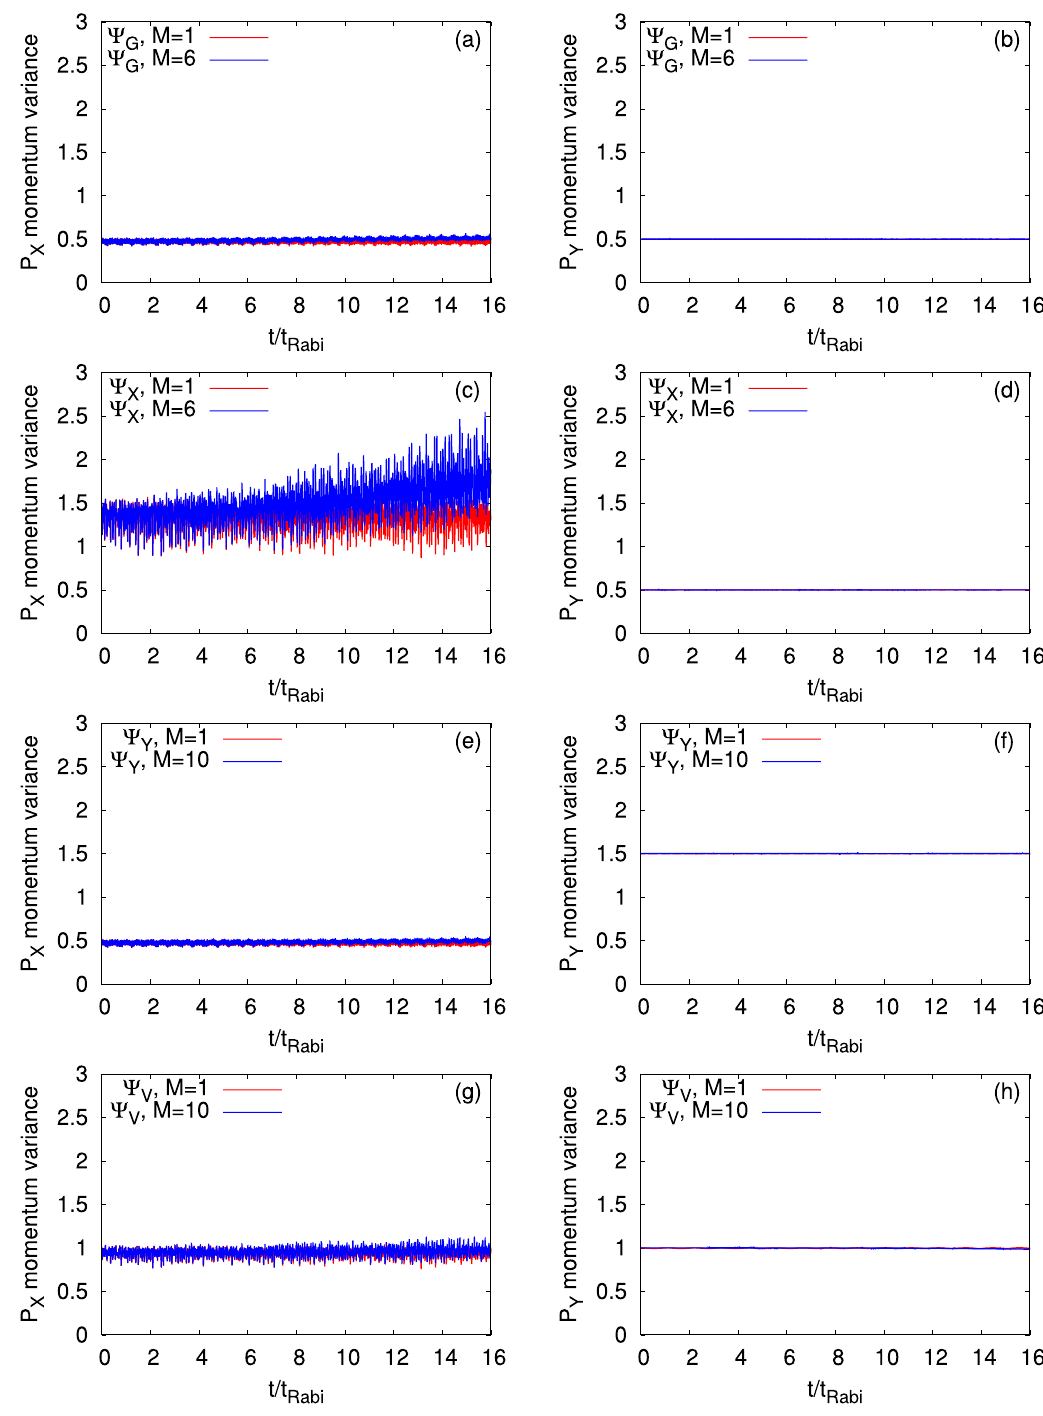
1 time-adaptive orbitals, in red) and many-body (in blue) time-dependent = 1 1 � 2 ( t ) and � 2 ( t ) , are presented in the left and right columns, respectively. N N ˆ P X ˆ P Y 10 bosons are plotted row-wise. The many-body results = 6 orbitals for (cid:31) 10 orbitals for (cid:31) G and (cid:31) X and M = Y and =